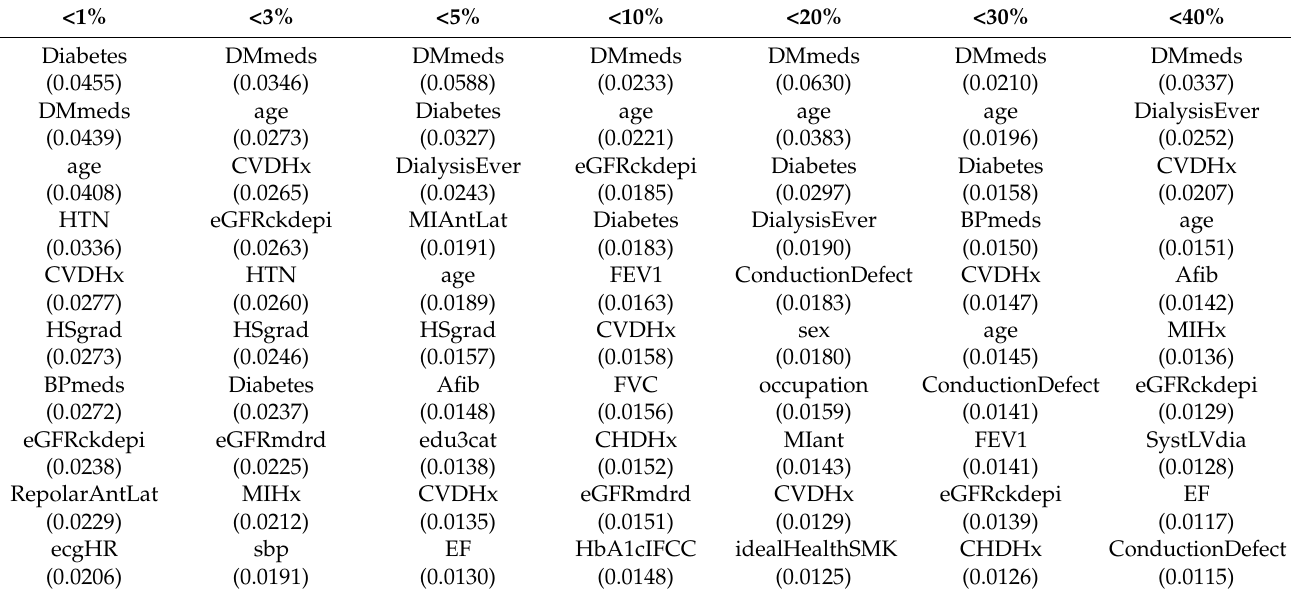
Table 3. The selected parameters of the final HF prediction model for XGBoost using simple imputations.